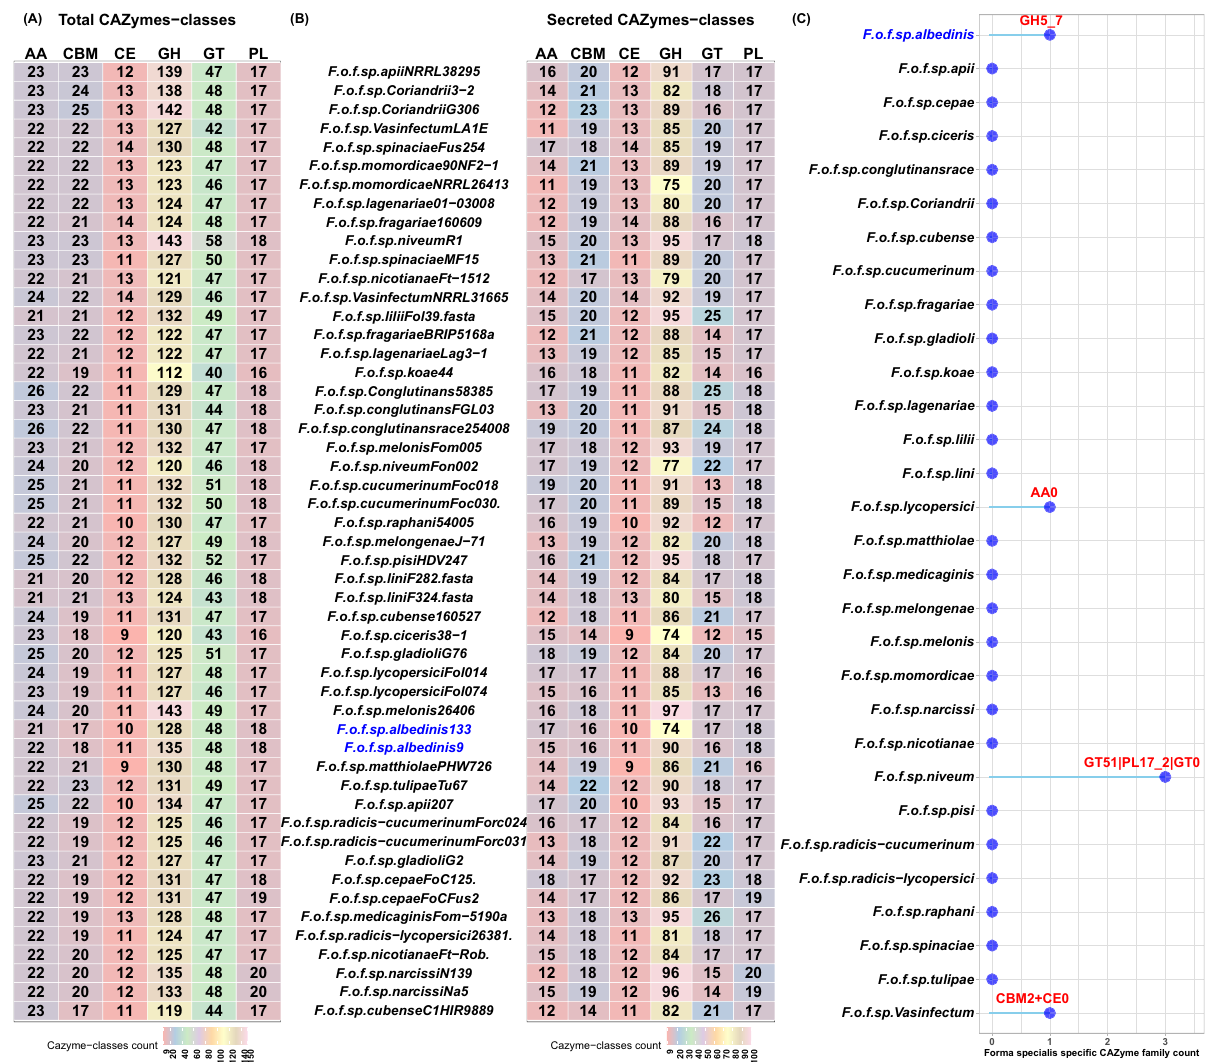
F.o.f.sp.VasinfectumF.o.f.sp.tulipaeF.o.f.sp.spinaciaeF.o.f.sp.raphaniF.o.f.sp.radicis−lycopersiciF.o.f.sp.radicis−cucumerinumF.o.f.sp.pisiF.o.f.sp.niveumF.o.f.sp.nicotianaeF.o.f.sp.narcissiF.o.f.sp.momordicaeF.o.f.sp.melonisF.o.f.sp.melongenaeF.o.f.sp.medicaginisF.o.f.sp.matthiolaeF.o.f.sp.lycopersiciF.o.f.sp.liniF.o.f.sp.liliiF.o.f.sp.lagenariaeF.o.f.sp.koaeF.o.f.sp.gladioliF.o.f.sp.fragariaeF.o.f.sp.cucumerinumF.o.f.sp.cubenseF.o.f.sp.CoriandriiF.o.f.sp.conglutinansraceF.o.f.sp.cicerisF.o.f.sp.cepaeF.o.f.sp.apiiF.o.f.sp.albedinis F.o.f.sp.cubenseC1HIR9889F.o.f.sp.narcissiNa5F.o.f.sp.narcissiN139F.o.f.sp.nicotianaeFt−Rob.F.o.f.sp.radicis−lycopersici26381.F.o.f.sp.medicaginisFom−5190aF.o.f.sp.cepaeFoCFus2F.o.f.sp.cepaeFoC125.F.o.f.sp.gladioliG2F.o.f.sp.radicis−cucumerinumForc031F.o.f.sp.radicis−cucumerinumForc024F.o.f.sp.apii207F.o.f.sp.tulipaeTu67F.o.f.sp.matthiolaePHW726F.o.f.sp.albedinis9F.o.f.sp.albedinis133F.o.f.sp.melonis26406F.o.f.sp.lycopersiciFol074F.o.f.sp.lycopersiciFol014F.o.f.sp.gladioliG76F.o.f.sp.ciceris38−1F.o.f.sp.cubense160527F.o.f.sp.liniF324.fastaF.o.f.sp.liniF282.fastaF.o.f.sp.pisiHDV247F.o.f.sp.melongenaeJ−71F.o.f.sp.raphani54005F.o.f.sp.cucumerinumFoc030.F.o.f.sp.cucumerinumFoc018F.o.f.sp.niveumFon002F.o.f.sp.melonisFom005F.o.f.sp.conglutinansrace254008F.o.f.sp.conglutinansFGL03F.o.f.sp.Conglutinans58385F.o.f.sp.koae44F.o.f.sp.lagenariaeLag3−1F.o.f.sp.fragariaeBRIP5168aF.o.f.sp.liliiFol39.fastaF.o.f.sp.VasinfectumNRRL31665F.o.f.sp.nicotianaeFt−1512F.o.f.sp.spinaciaeMF15F.o.f.sp.niveumR1F.o.f.sp.fragariae160609F.o.f.sp.lagenariae01−03008F.o.f.sp.momordicaeNRRL26413F.o.f.sp.momordicae90NF2−1F.o.f.sp.spinaciaeFus254F.o.f.sp.VasinfectumLA1EF.o.f.sp.CoriandriiG306F.o.f.sp.Coriandrii3−2F.o.f.sp.apiiNRRL38295 Figure 6. Predicted CAZymes in the analyzed strains. ( A ): heat map showing the total number of CAZymes distributed on six categories: auxiliary activities (AA), carbohydrate-binding molecules (CBM), carbohydrate esterases (CE), glycoside hydrolases (GH), glycosyltransferases (GT) and polysaccharide lyases (PL). ( B ): heat map showing the number of secreted CAZymes for each strain. ( C ): lollipop plot representing CAZyme families specific to each formae speciales . Abbreviations: F (Fusarium); o (oxysporum); f (forma); sp (specialis). The names following the abbreviations represent the names of the formae speciales ; the abbreviations coming after the names of the formae speciales correspond to the strains belonging to these formae speciales (F.o.f.sp. albedinis 133: Fusarium osysporum forma specialis albedinis Foa